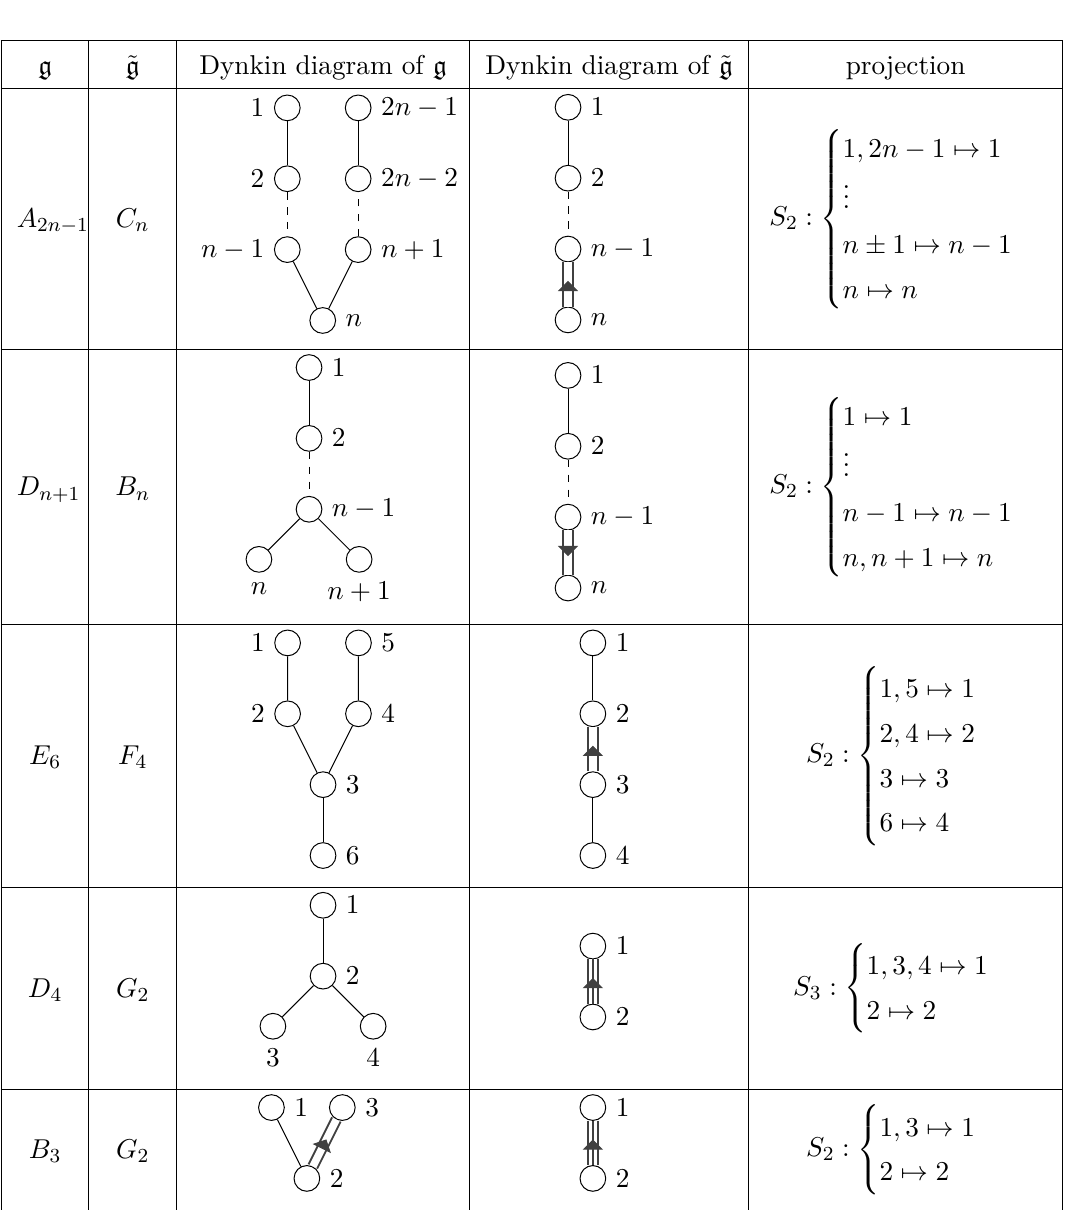
Table 3 . Foldable simple Lie algebras. Note that numbers label nodes and do not indicate gauge groups as these are not quiver theories. The S 2 last row is a special case treated in several places in the main